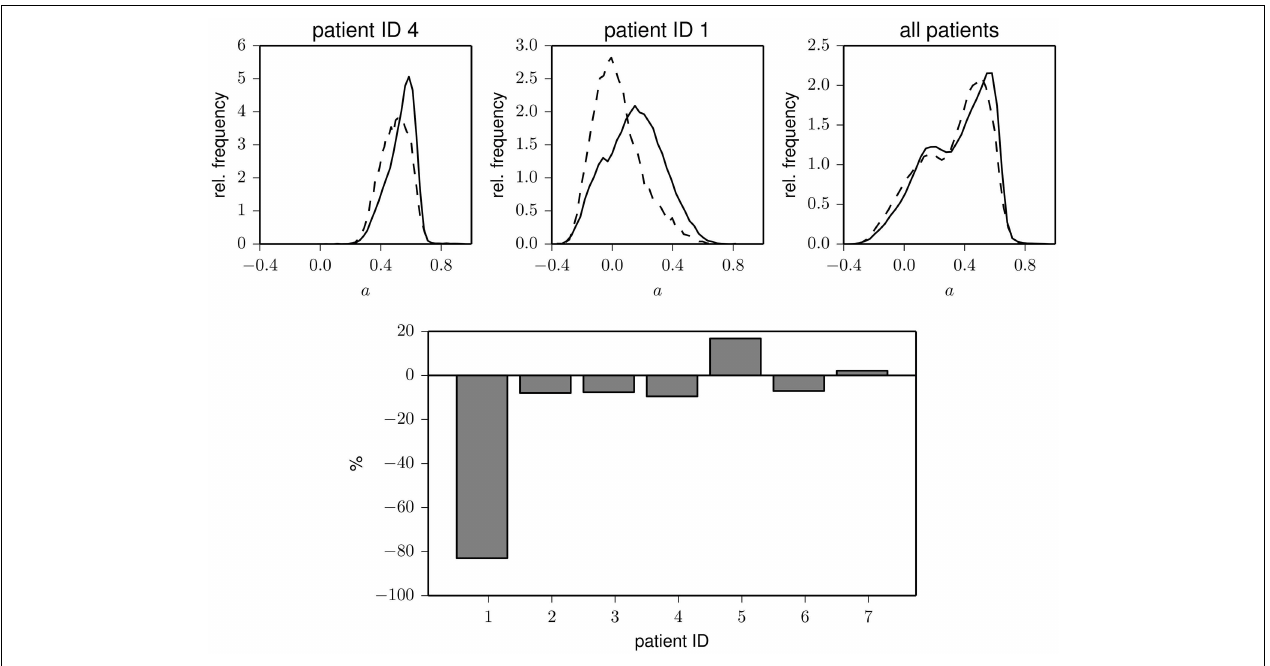
FIGURE 2 | Top: Exemplary frequency distributions of the assortativity coefficient derived from data recorded during day (solid) and night times (dashed) for two patients (left and middle) and for the pooled data from all